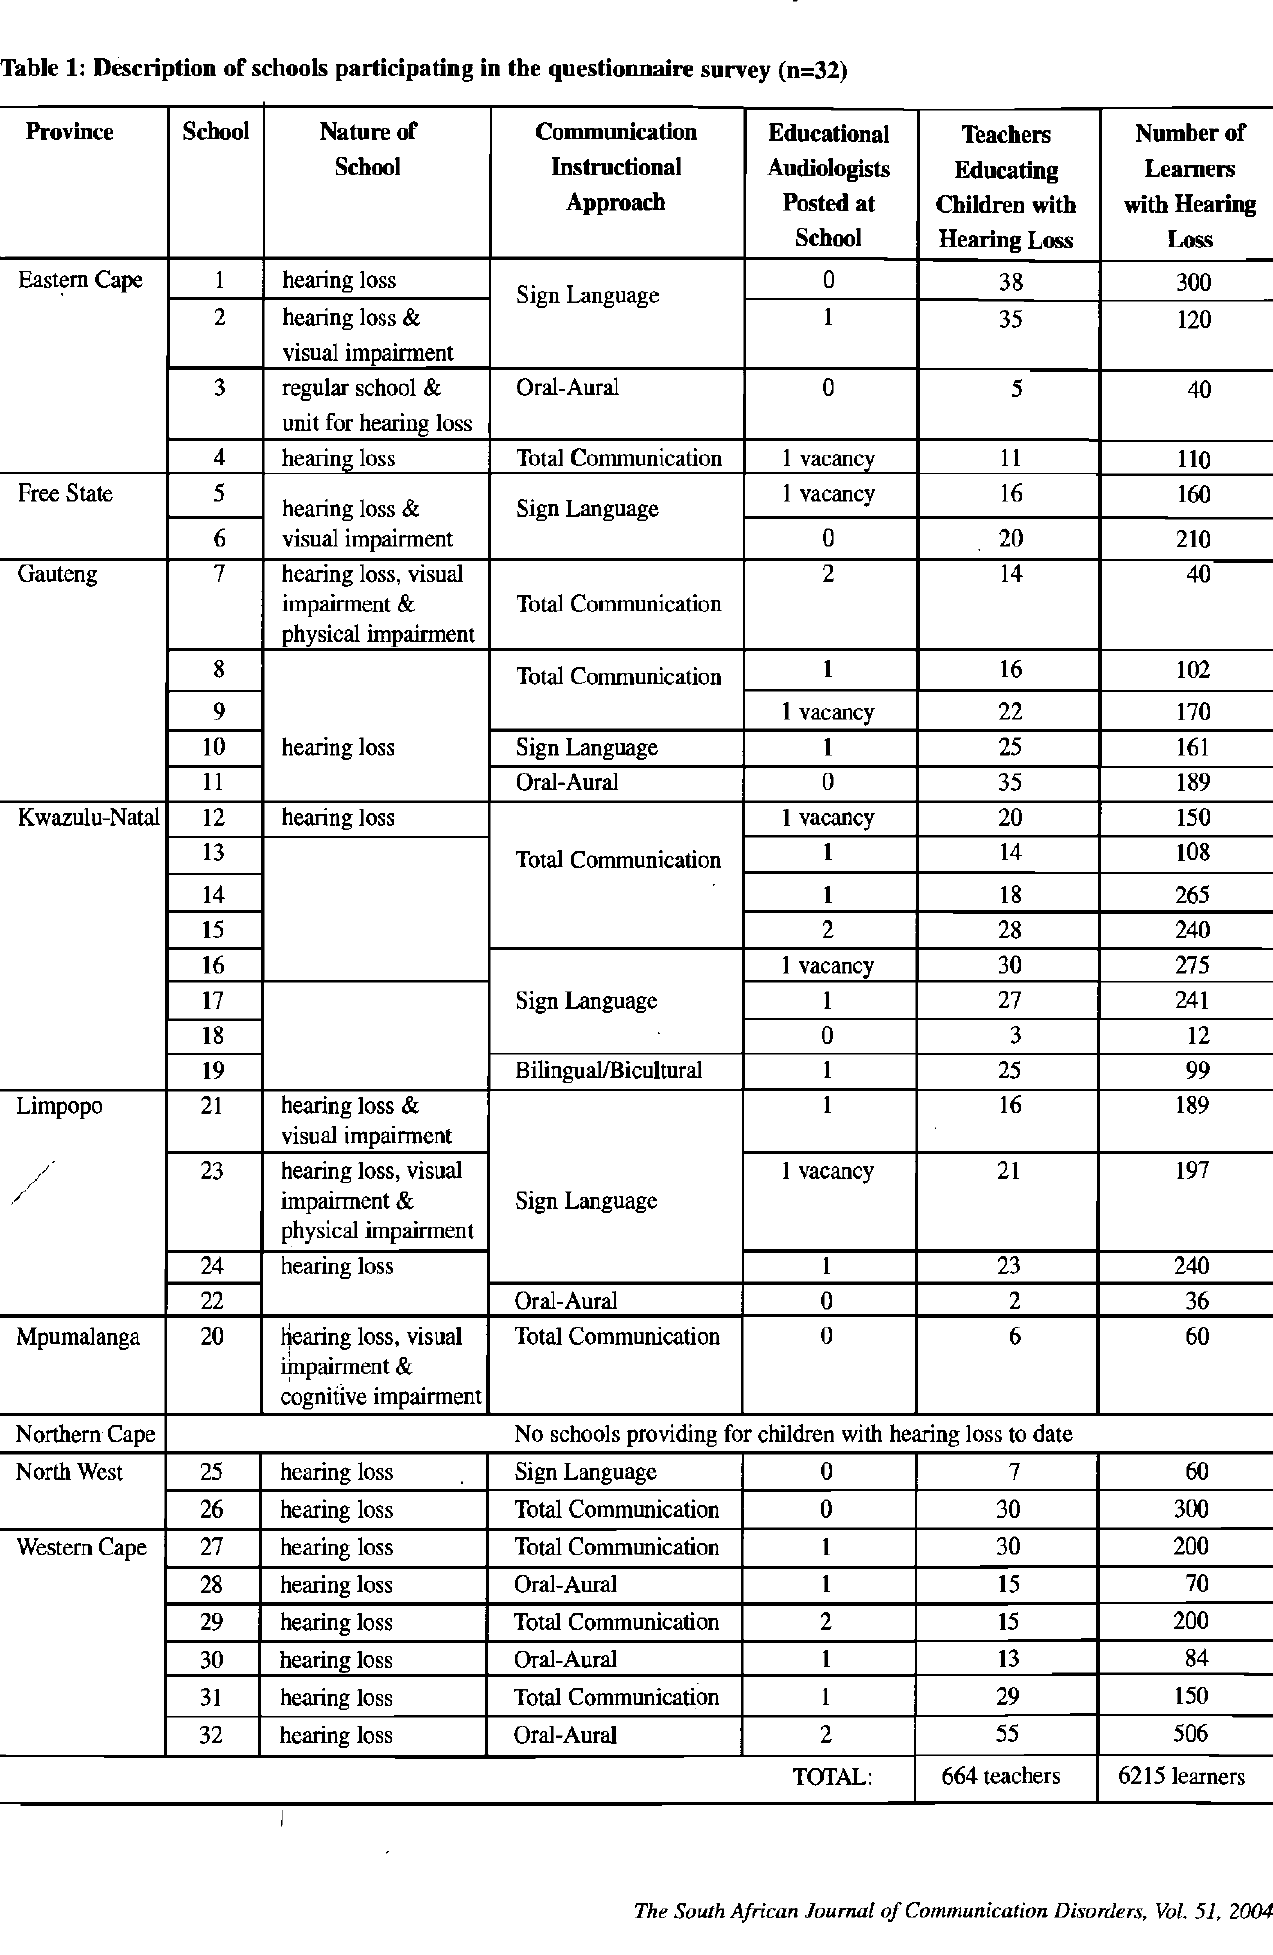
Table 1: Description of schools participating in the questionnaire survey (n=32) Province School Nature of Communication Educational Teachers School Instructional Learners Approach Posted